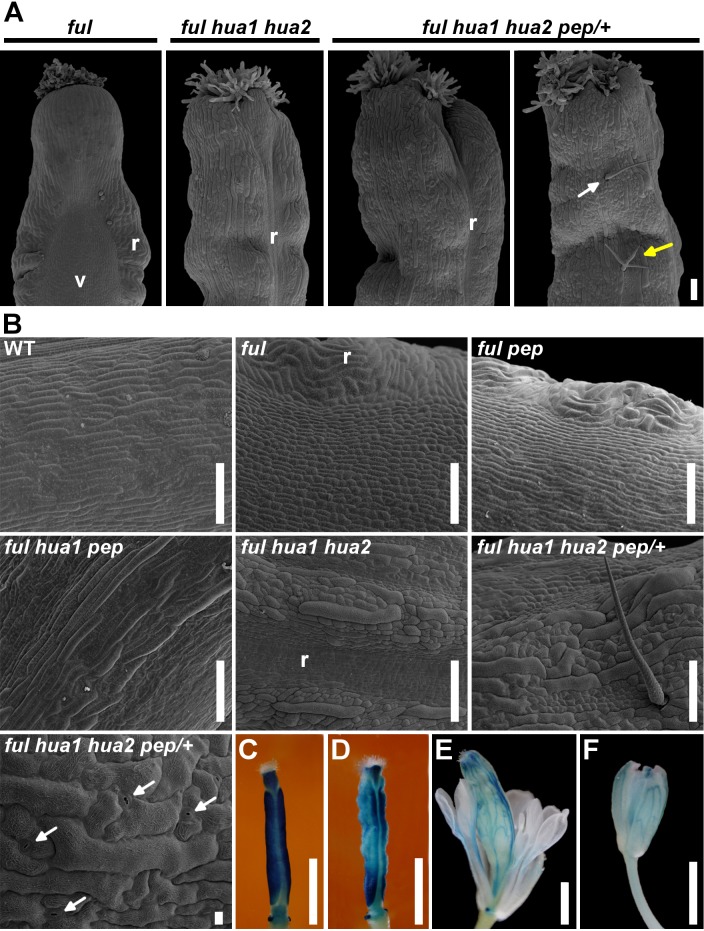
The loss of HUA-PEP activity is epistatic over the ful phenotype.A) SEM images of the top portion of a ful fruit. The typical long style and wide zig-zag replum were suppressed in ful hua1 hua2 and ful hua1 hua2 pep/+ pistils, and sepaloid giant cells were observed on the valve surface. Simple or branched trichomes (white and yellow arrows, respectively) were occasionally observed on the surface of ful hua1 hua2 pep/+ pistils. B) SEM images of the abaxial ovary surface in wild-type (WT) and different mutant backgrounds. Observe interspersed stomata (arrows) in a ful hua1 hua2 pep/+ panel. C-F) GUS reporter whole-mount staining (ful-1) in ful (C), ful hua1 hua2 (D), ful hua1 hua2 pep/+ (E) pistils and wild-type sepal (F). Observe long gynophores and full petaloid conversion of stamens in (E). Scale bars: 100 μm (A, B), except 10 μm in the last B panel (ful hua1 hua2 pep/+ genotype), and 1 mm (C-F). r, replum; v, valve.